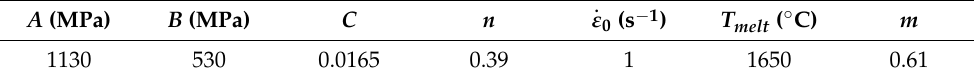
Table 4. Johnson and Cook model parameters for Ti6Al4V alloy